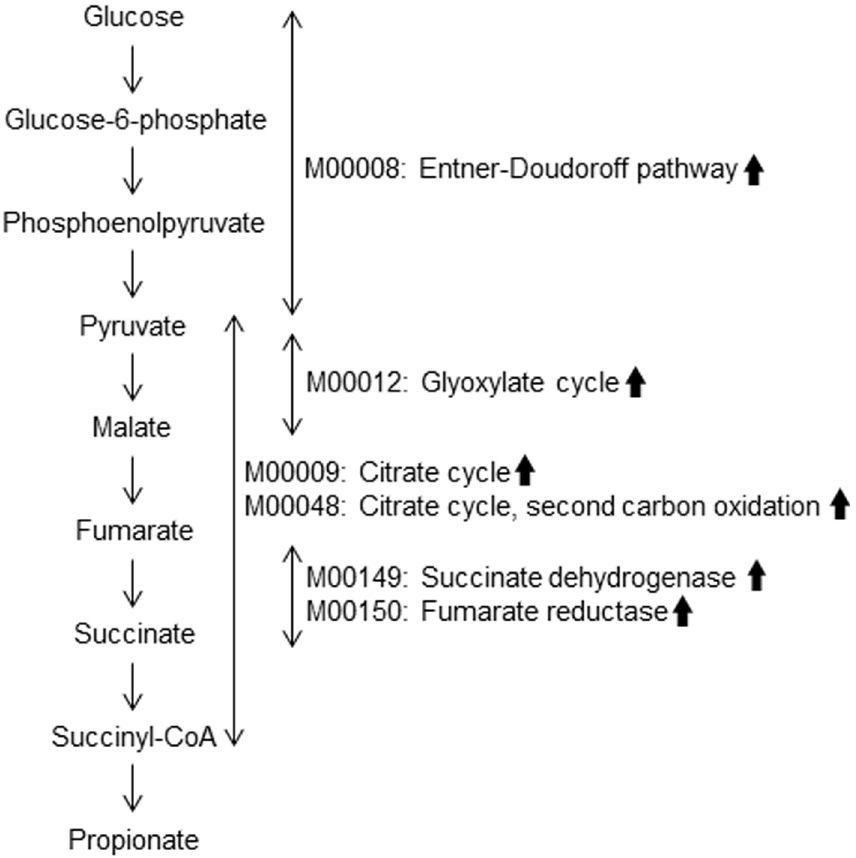
Fig 2. Schematic representation of succinate-propionate pathway and its alterations in patients with RP. Several predominant gene functions of RP gut microbiota of this study (arrows) corresponded to several components of the succinate-propionate pathway. Veillonella species, Bacteroides species, and Acidaminococcus species utilize the pathway for the propionate production.